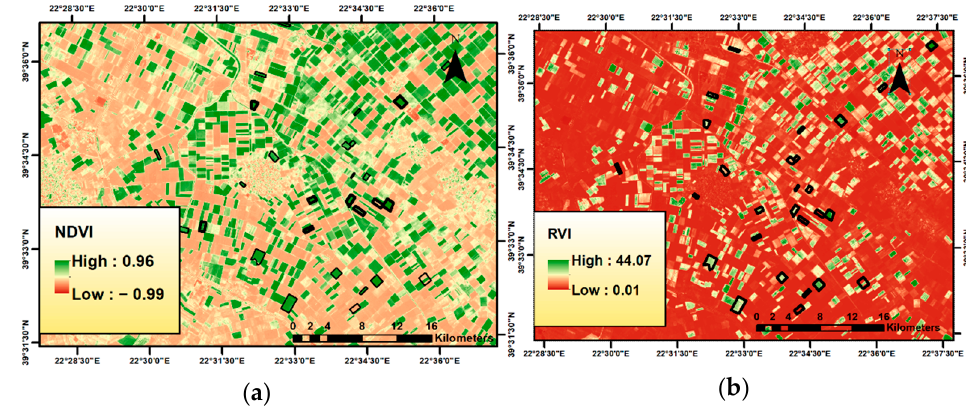
Figure 2. A segment of the study area in the wider area of Larissa: ( a ) NDVI; ( b ) RVI. The same spectral bands were used for RVI (ratio vegetation index or simple ratio vegetation index), which is recorded to improve both saturation in high vegetation and sensitivity to the soil in low vegetation compared with NDVI [38]. It was introduced by Pearson and Miller [34]) and is based on the contrast between the visible red and far- infrared bands of electromagnetic radiation for the pixels corresponding to vegetation [34]. High values of the index are mainly attributed to healthy vegetation and result from the combination of its low reflectance value for the red and the high reflectance it presents in the near-infrared band. Its value range is from 0 to more than 30, with healthy vegetation usually presenting values of 2 to 8 (Figure 2b). Richardson and Wiegand [33] approached the problem of variable soil brightness by developing the perpendicular vegetation index (PVI), which attempts to eliminate differences in soil background (Figure 3a) [33]. It can be computed as a spectral indicator of plant development or biomass accumulation and cannot be considered to be independent of soil brightness. While it is effective in removing soil brightness effects for bare soil, it quickly becomes more sensitive as the canopy develops. A PVI value of 0 indicates bare soil, whereas negative values indicate water and positive values indicate vegetation. It is less sensitive to the atmosphere but is considered sensitive to the reflectivity and brightness of the ground, especially in cases with low vegetation cover. The weakness presented by PVI regarding the assumption that there will be only one soil type under vegetation is addressed by the soil-adjusted vegetation index (SAVI), which was proposed by Huete [35] and is a hybrid of NDVI and PVI . The originality of this index lies in the establishment of a simple model that permits an adequate description of the soil–vegetation system [39]. SAVI (Figure 3b) also attempts to eliminate soil background effects; however, it is much less sensitive to changes in the background caused by soil color or surface soil moisture content than the ratio vegetation index [40]. Qi et al. [41] shoed that the adjustment factor (L) is not a constant but a function that varies inversely with the amount of vegetation present. Generally, it is best applied to soils with sparse vegetation, and its range of desired values is the same as that of NDVI [42].